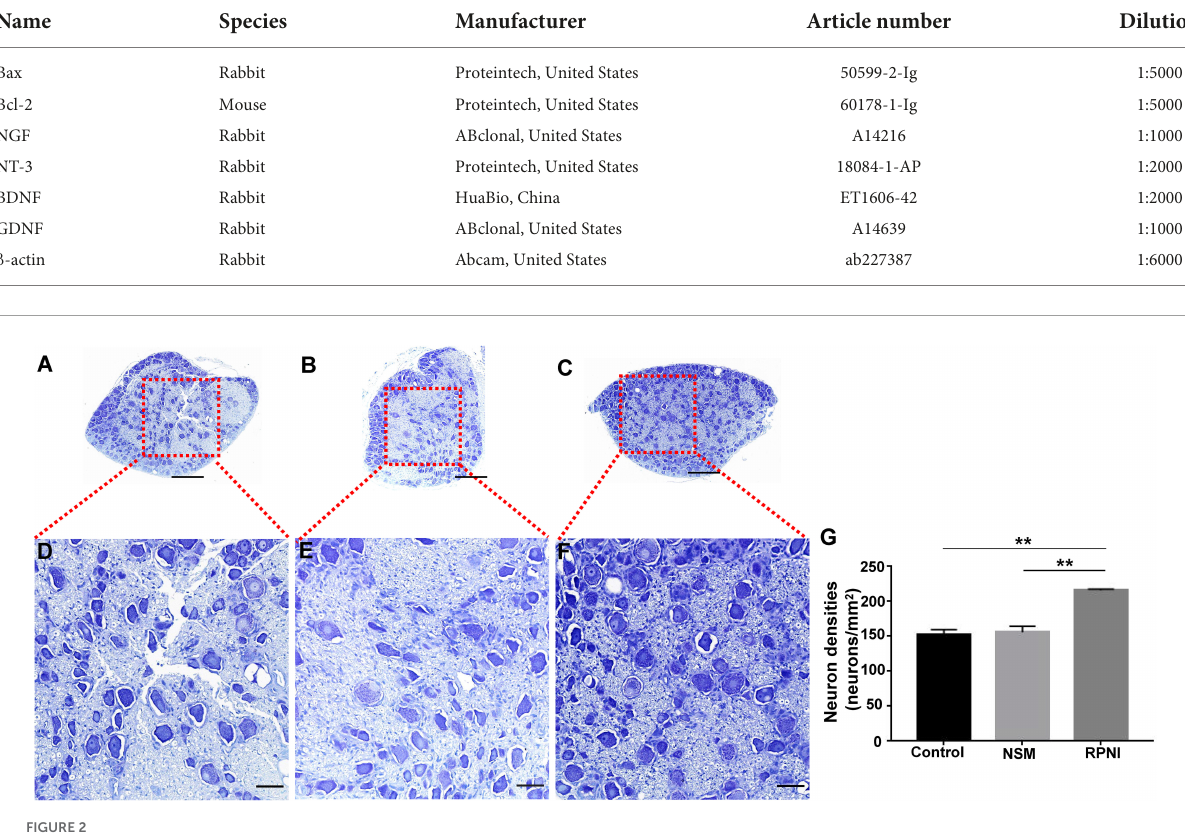
TABLE 1 The relevant information of the primary antibodies.